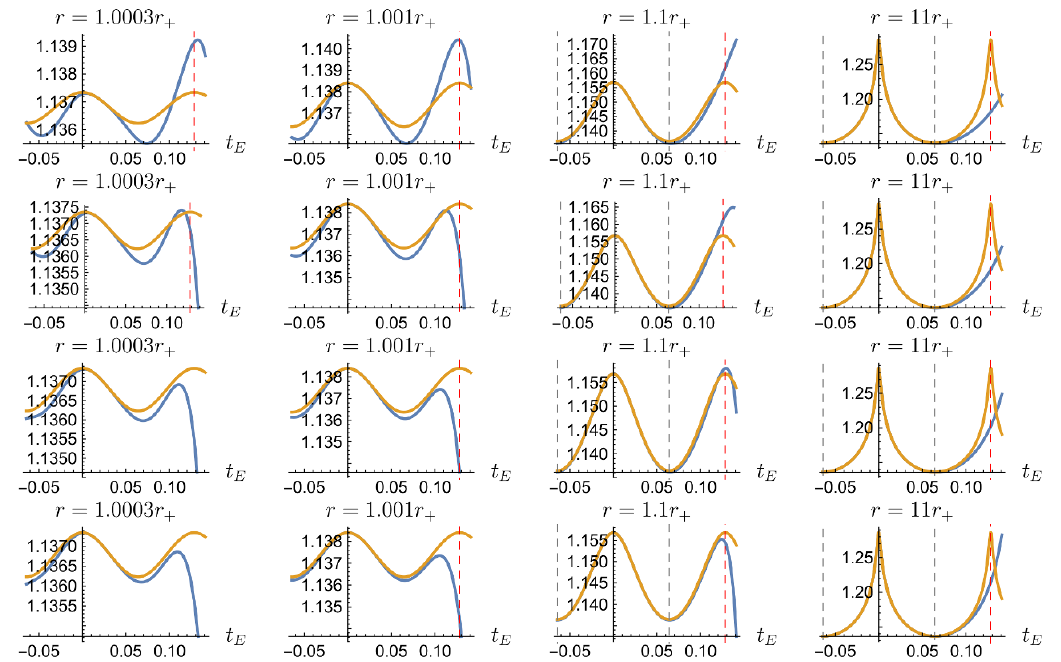
exact and the yellow lines are the semiclassical 0 j jV = 100, and r + 50. The (cid:12)rst two plots in each c (cid:25) (cid:12)= 2. The exact results in the visible (cid:6)